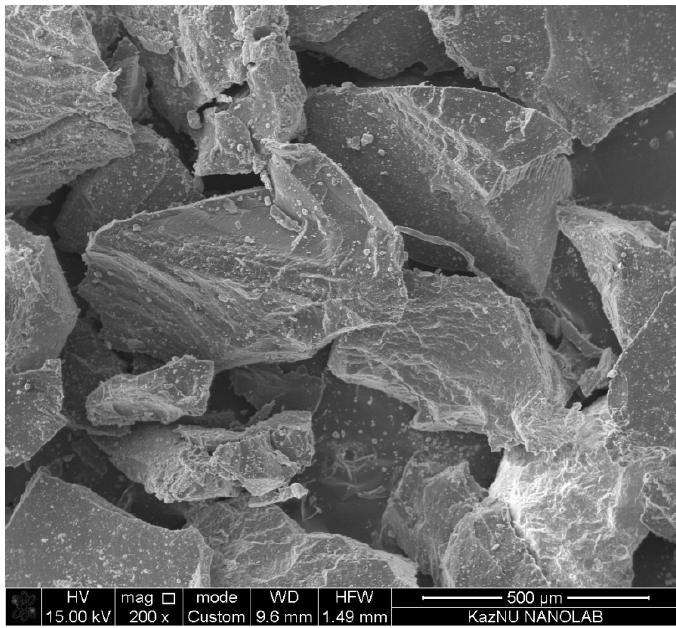
Figure 9. SEM—cryodestructed crumb rubber sample illustration.